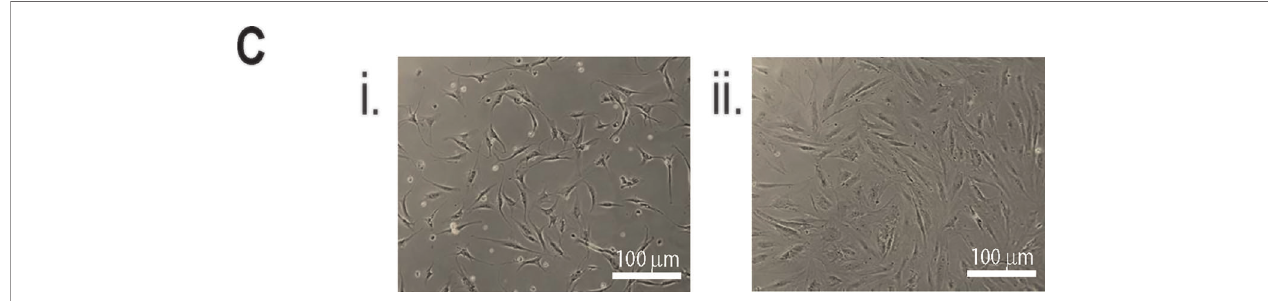
FIGURE 1 | Untouched adipose-derived stem cell (ASC) can be enriched from the stromal vascular fraction (SVF) using an antibody cocktail to deplete contaminating cell populations. A fl ow cytometry panel was used to demonstrate exclusion gating of CD45, CD31, CD235a, and CD146 cells enriched for CD90 +CD73+CD34+ ASC cells within the SVF (A) . Therefore, a FITC antibody cocktail containing anti-CD45, -CD31, -CD235a, and -CD146 and anti-FITC microbeads was used to enrich ASC from SVF single cell digests using the “ MACS ” protocol. (B) Flow cytometry was used to assess the enrichment strategy: (1) presort, (2) the FITC+ fraction, and (3) the FITC depleted fraction with a panel of markers including CD73-PE, CD90-A700, CD31-APC-Cy7, CD45-BUV395, CD34-BV510, and CD146-BV711. Data shown are representative of four biological replicates. (C) The morphology of MACS-derived four days post sort (i) or culture-derived ASC 48 h post passage four (28 days) (ii) was assessed. This image is representative of at least